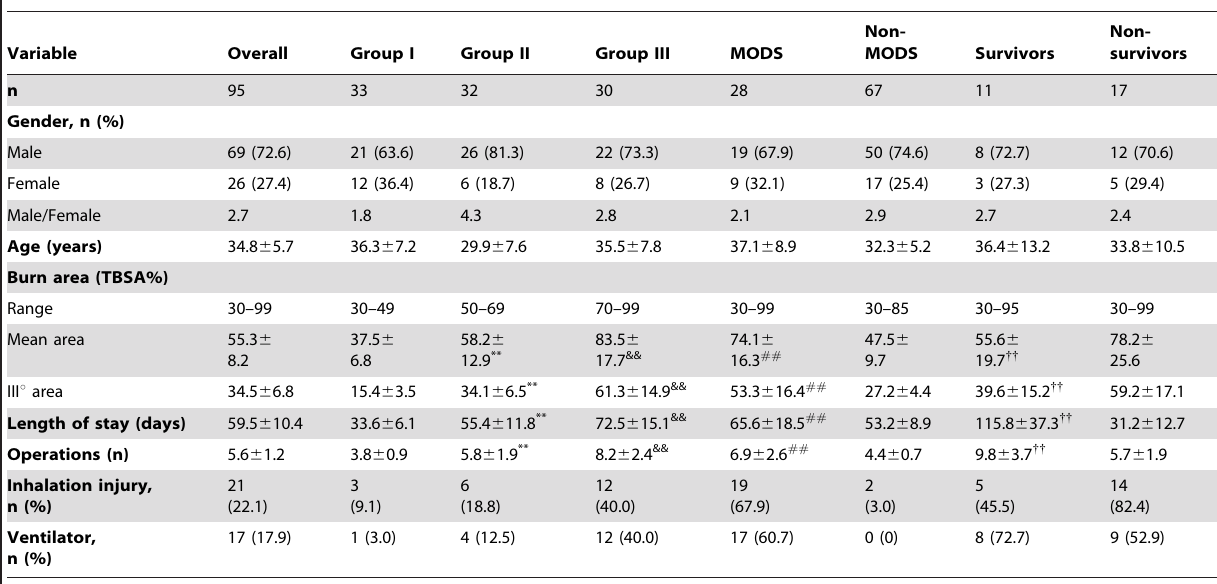
Table 2. Demographic and clinical characteristics of the patients.